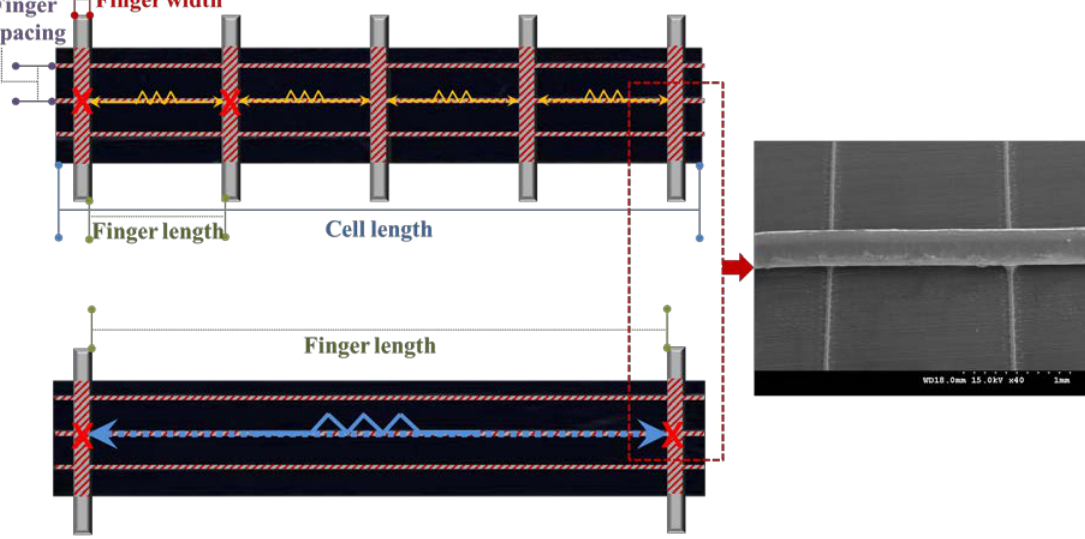
Figure 9. Schematic of the cause of the increase or decrease in efficiency based on the number of wires.